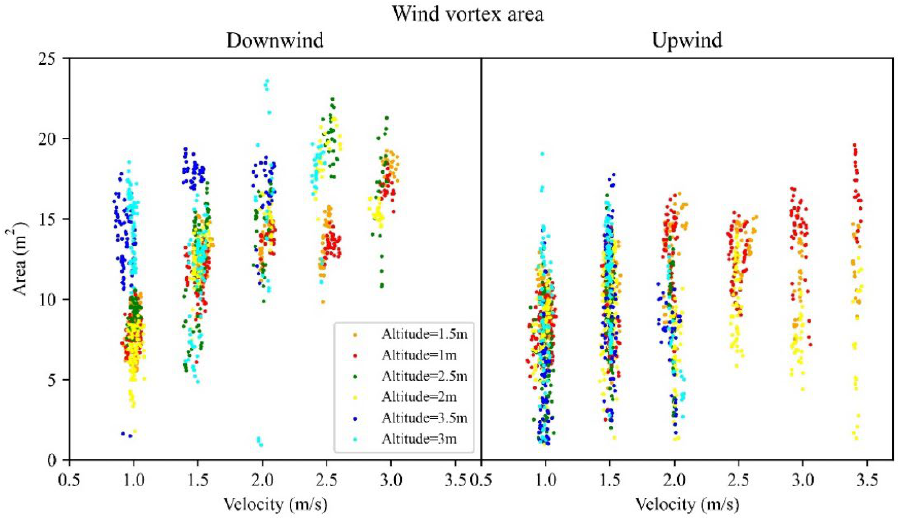
Figure 9. Scatter plot of wind -vortex area.